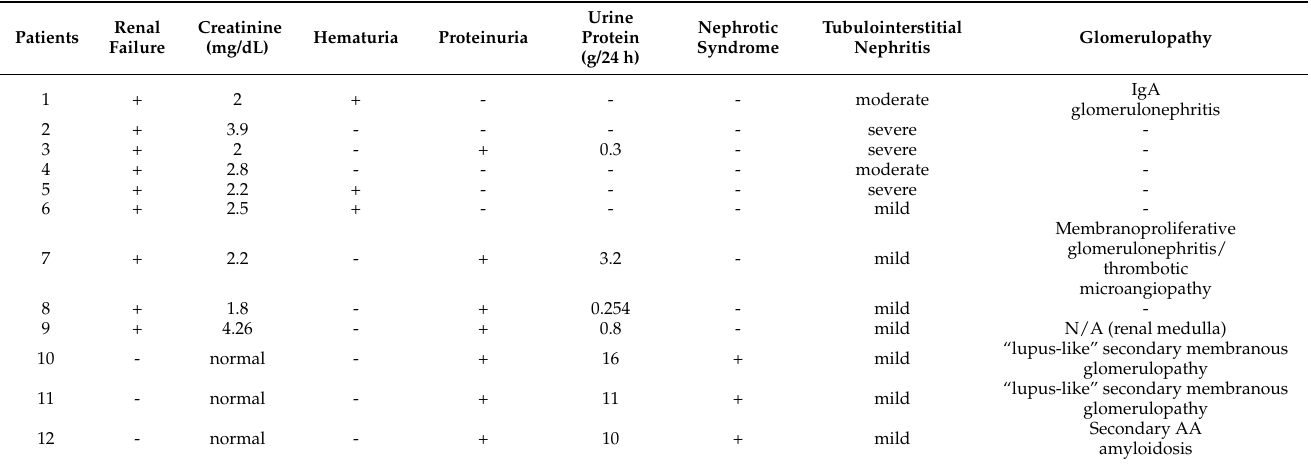
Table 2. This table summarizes the main clinical manifestations of renal toxicity in our patients and the prominent histological patterns encountered in their biopsies. Yes: +, No: -.